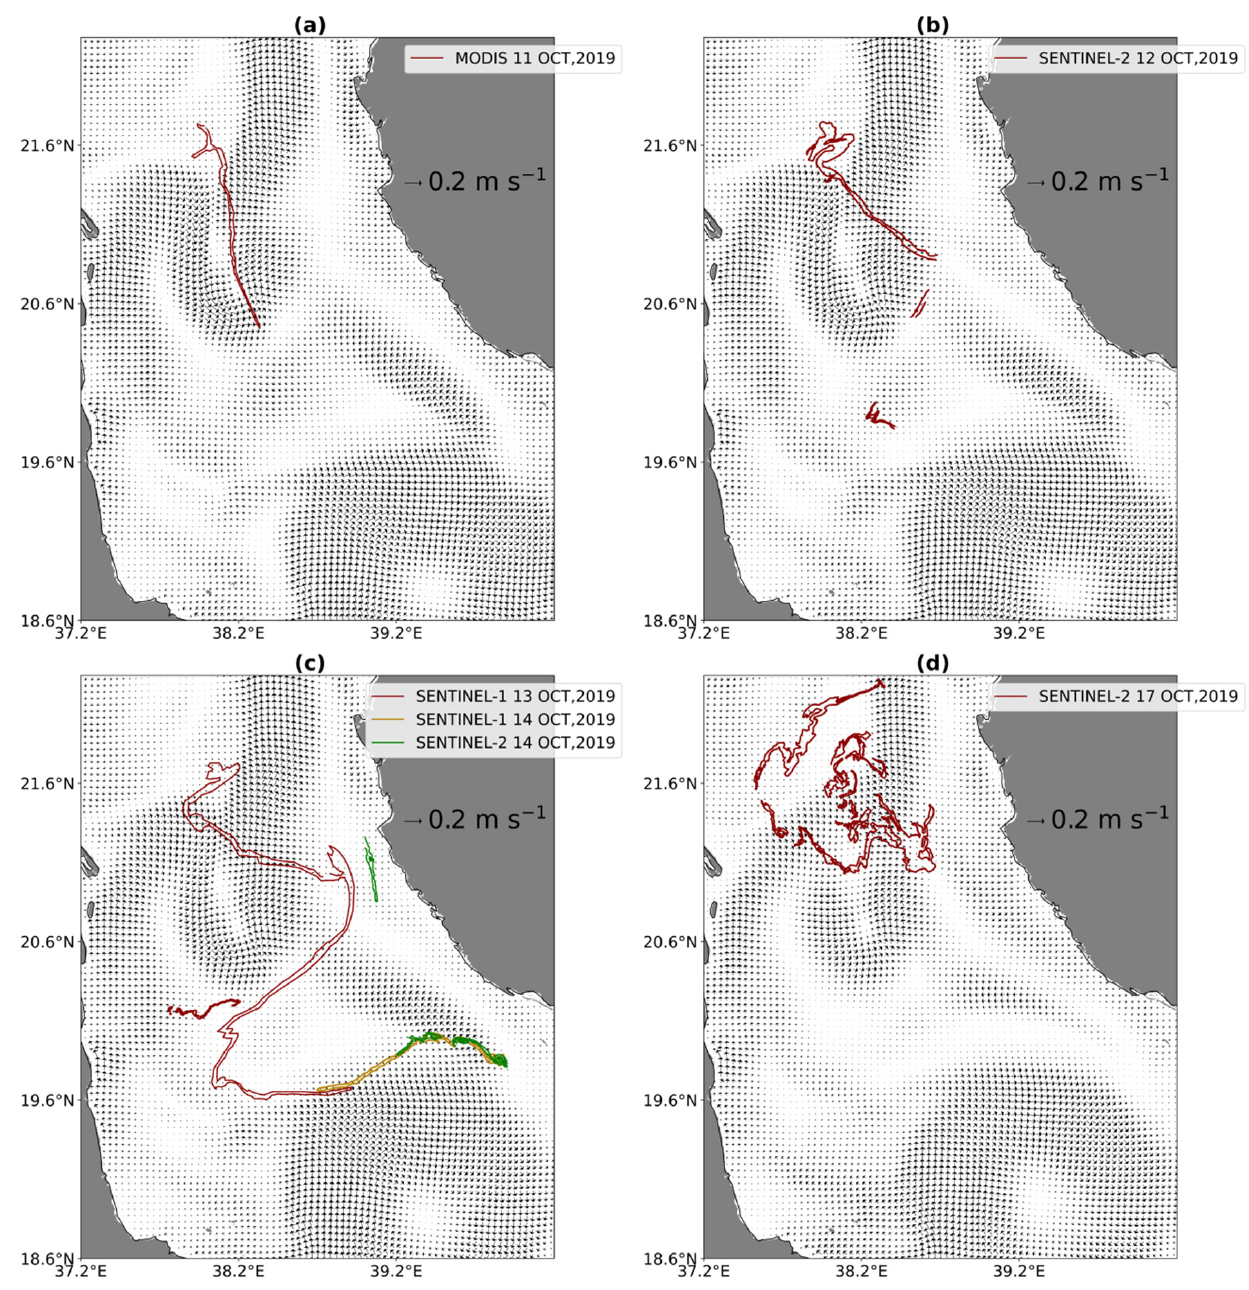
Figure 12. Evolution of model surface currents against the different satellite observations corresponding to ( a ) 11 October 2019 (the day of the accident), ( b ) 12 October 2019 (one day after the spill), ( c ) 13 and 14 October 2019 (two days after the spill), ( d ) 17 October 2019 (seven days after the spill). Color contours indicate the extent of the oil spill from different satellite observations.